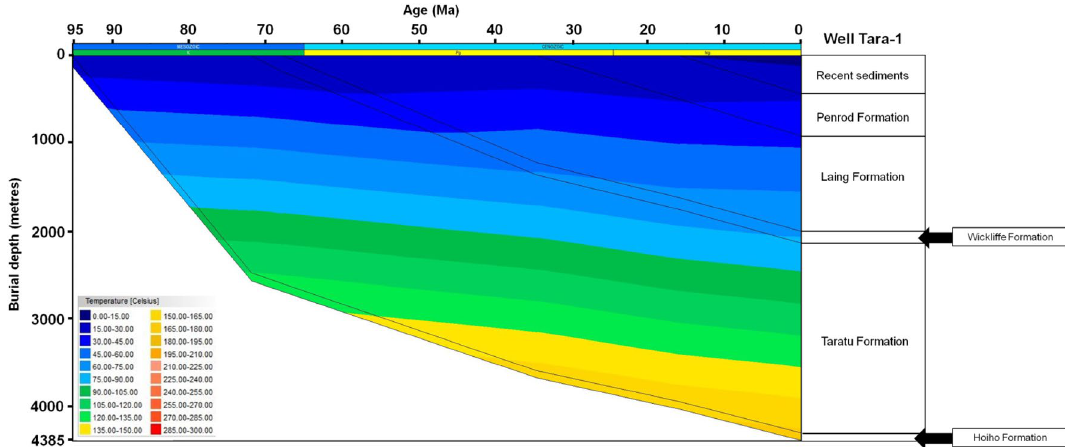
Fig. 12 Burial history with temperature variations for Tara-1